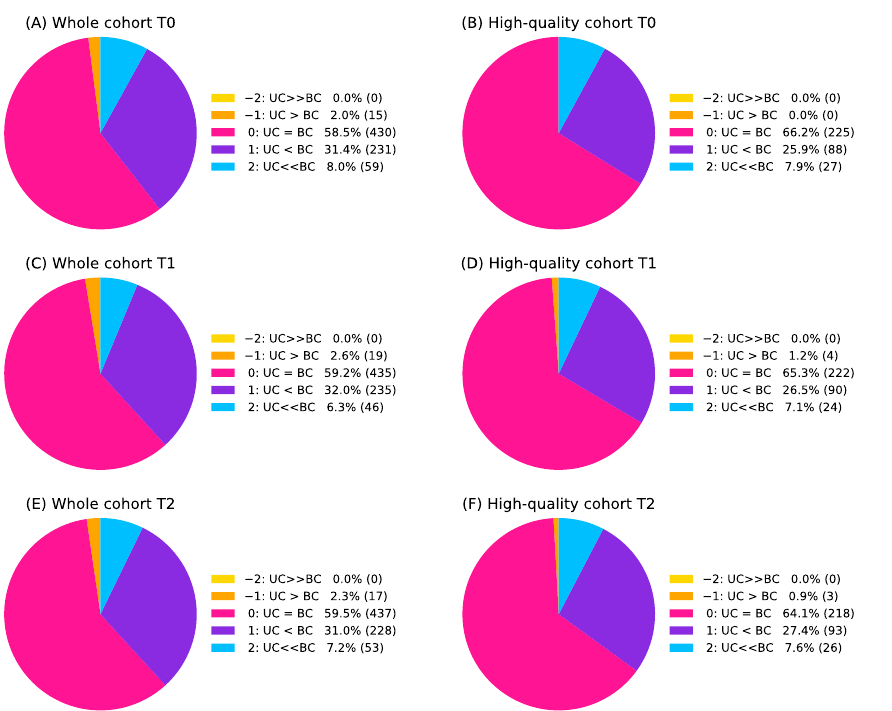
Figure 5. ( A – F ) Results for comparative visual assessment of uncorrected (UC) and bias-corrected (BC) BPE masks at each timepoint in the whole cohort and the high-quality cohort. Detailed expla- nations for the five categories ( − 2, − 1, 0, 1, 2) can be found in Table 1. Numbers in the parentheses are the number of examinations.